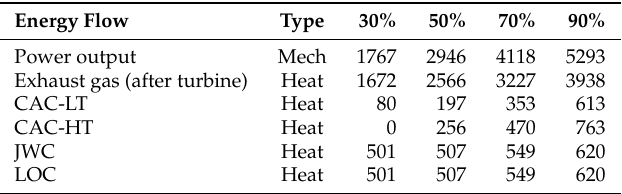
Table A3. Main engines, energy flows at different engine loads.